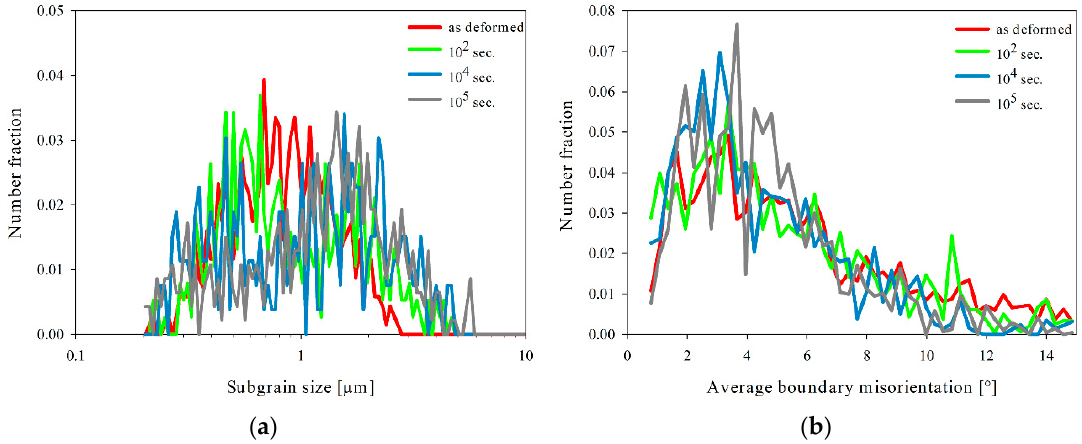
Figure 8. Size ( a ) and average boundary misorientation ( b ) distributions of subgrains with mixed orientations (orientation-independent) in CP Al.